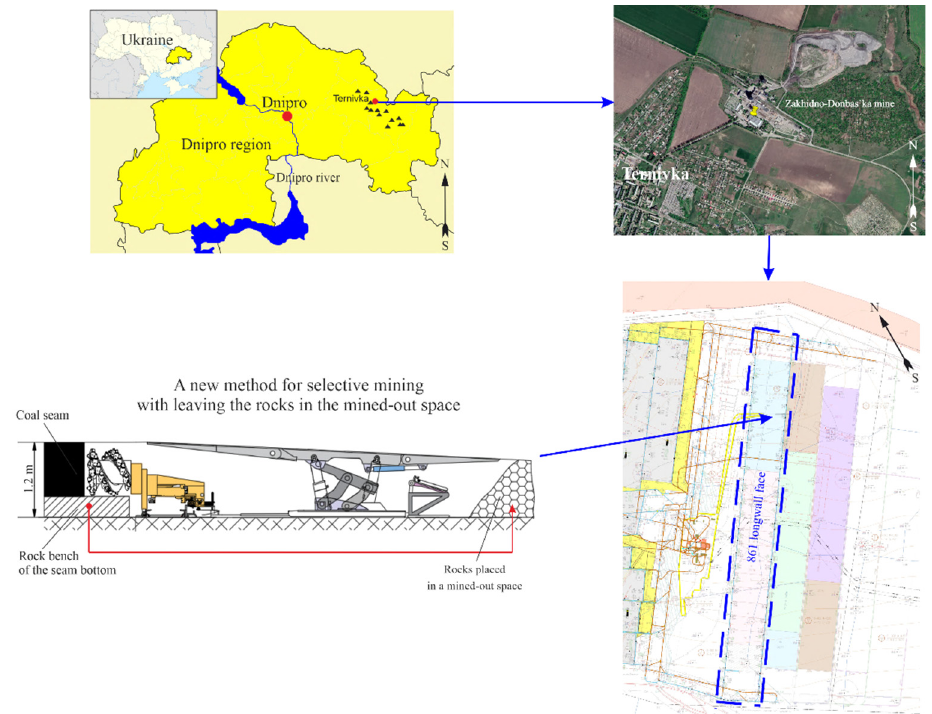
Figure 1. Layout of the mine and research object.